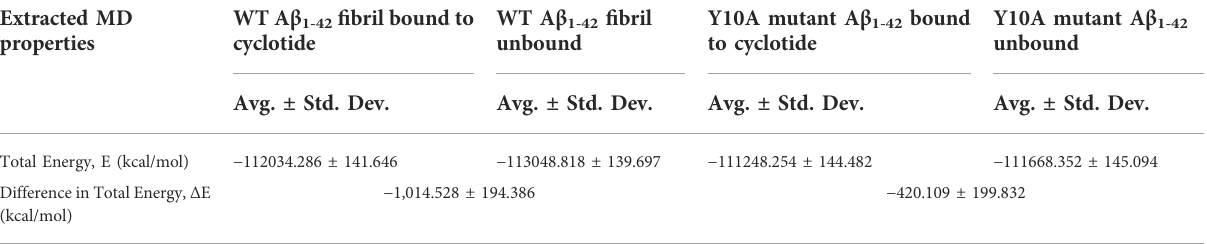
TABLE 3 Average total energy and Δ E =E bound — E unbound ,ofthe WT andY10Aforms ofA β 1-42 complexesboundto cyclotide andtheir corresponding control (unbound) trajectories across the 300 ns simulation time. Extracted MD